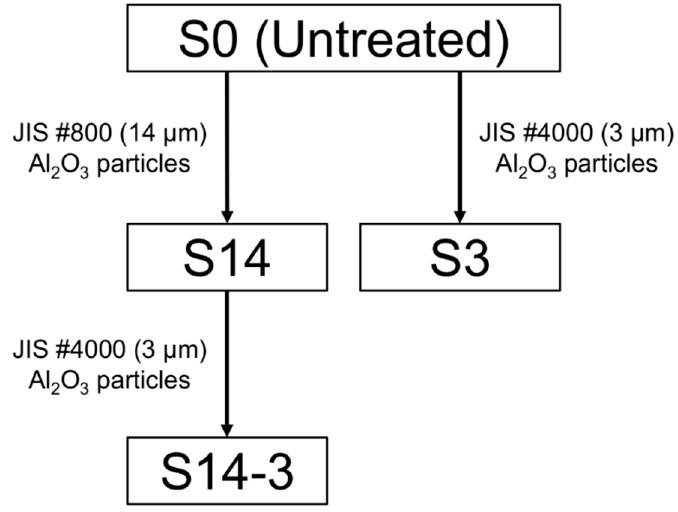
Figure 1. Flow chart of sandblasting processes and sample code for each condition.